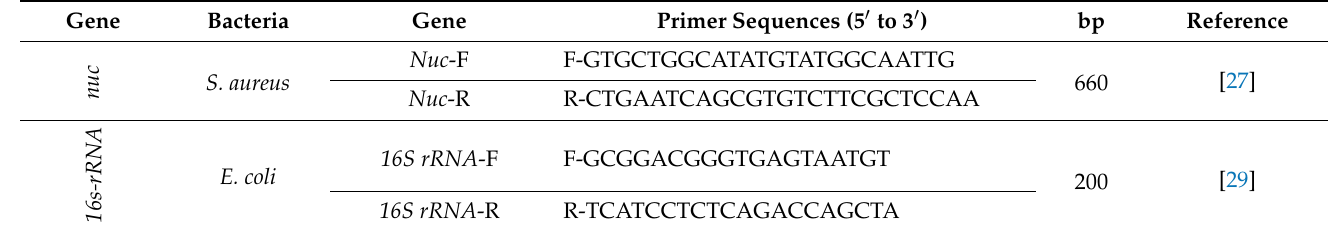
Table 1. Primers were used for amplification in this